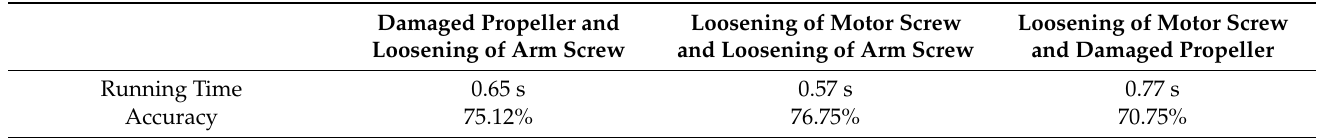
Table 8. The best double fault kNN classification model based on time-domain data